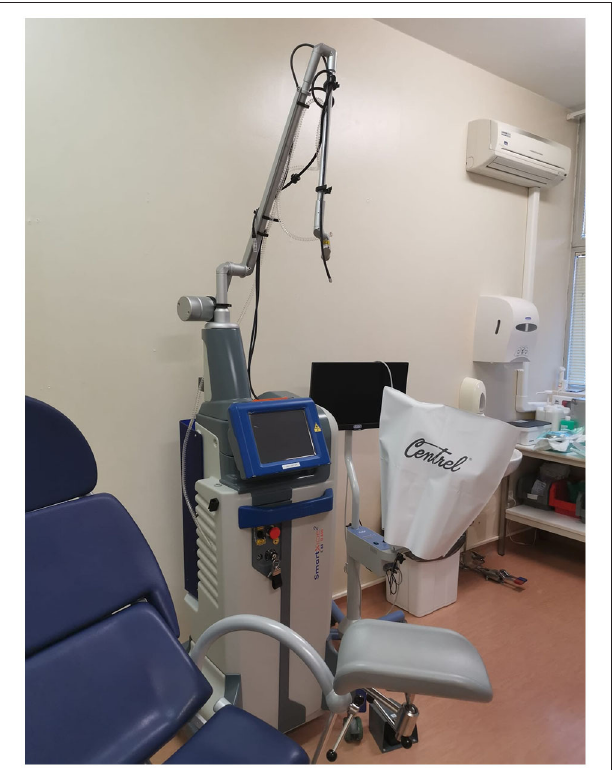
FIGURE 1 | Outpatient setting: SmartXide2 C80 laser